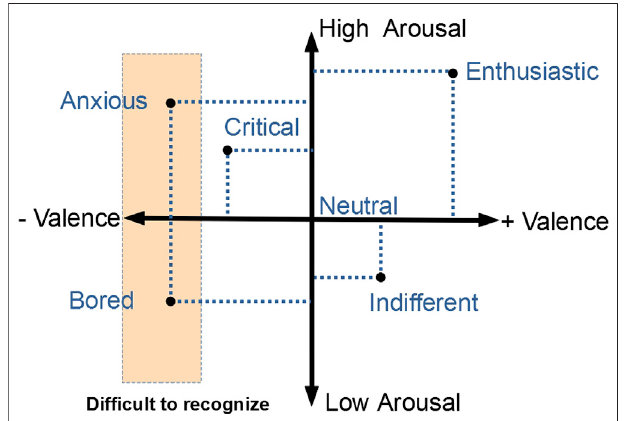
FIGURE 1 | Mapping of virtual audiences ’ attitudes on the models ’ dimensionsusing thecategorizationfrom Kang et al. (2016). On the horizontal axes the valence and on the vertical one the